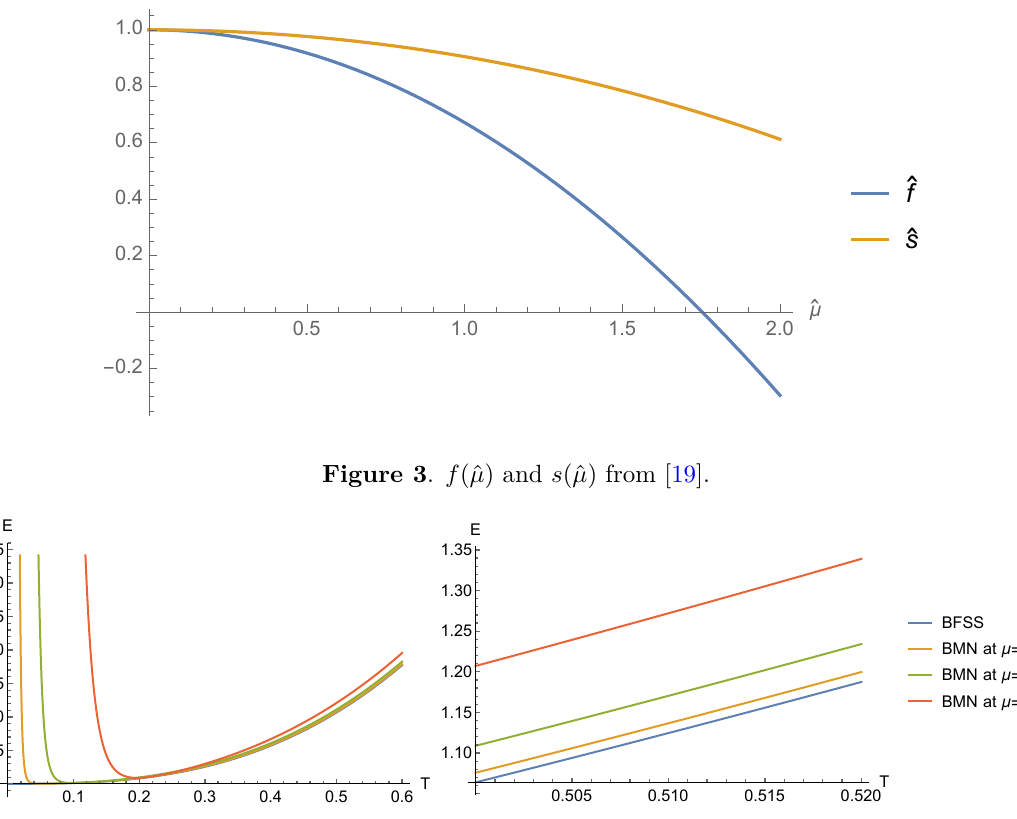
Figure 4 . [Left]: the energies in the supergravity limit at fixed values of µ as functions of temperature. [Right]: the same comparison zoomed in the region 0 . 5 ≤ T ≤ 0 . 52 . The blowing-up behavior in the left panel is due to the truncation of the expansions (3.22) and (3.23). Because the truncation of higher powers of ˆ µ = 7 µ is not valid at fixed µ and T → 0 , this blowing-up behavior 4 πT is